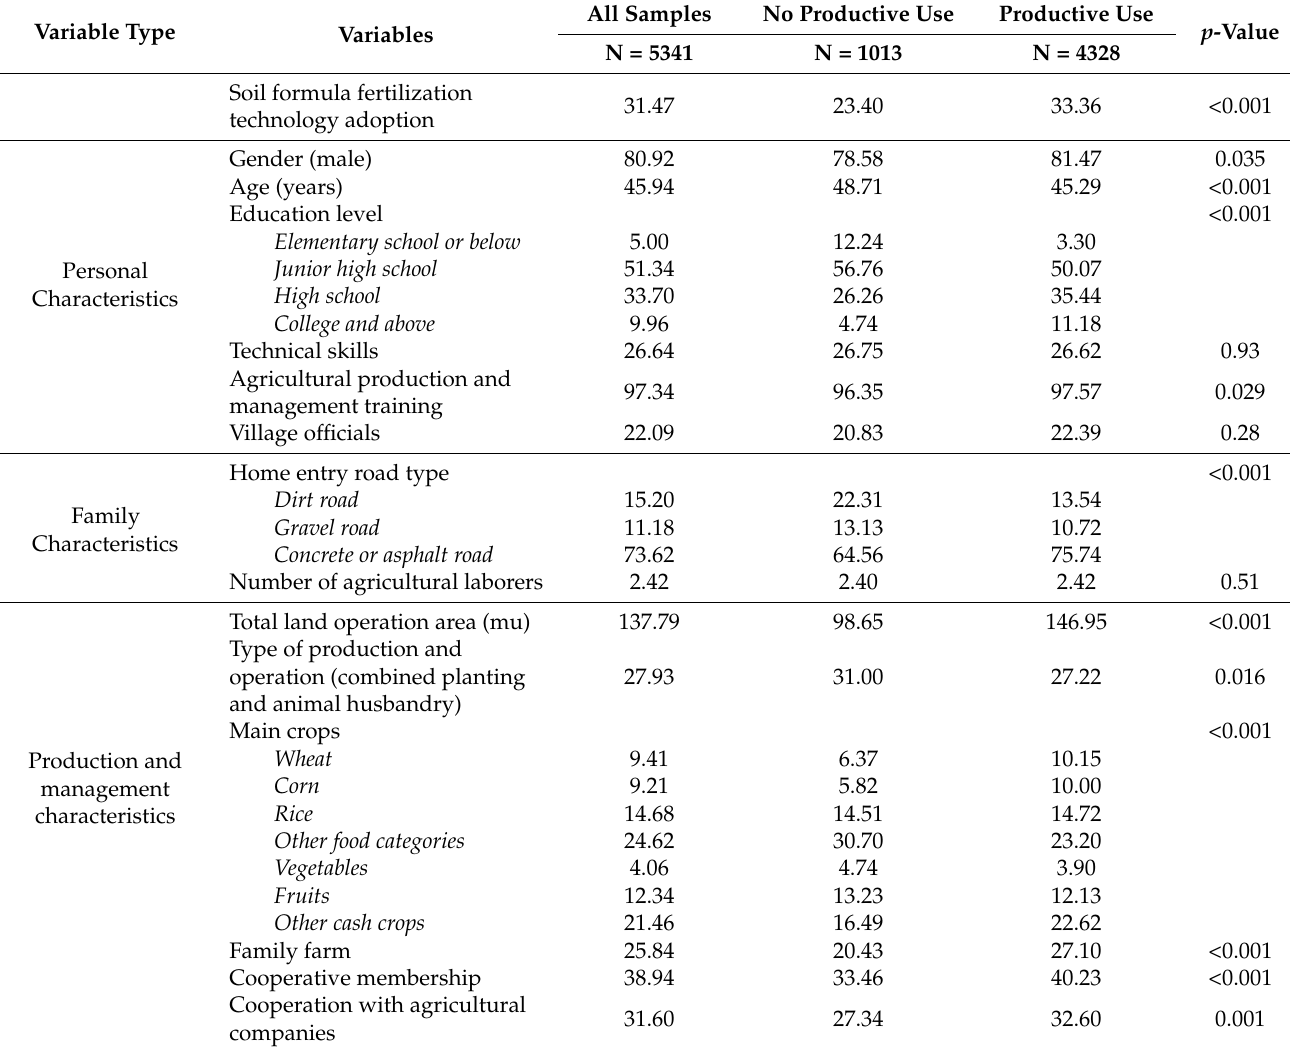
Table 2. Descriptive statistics of the main